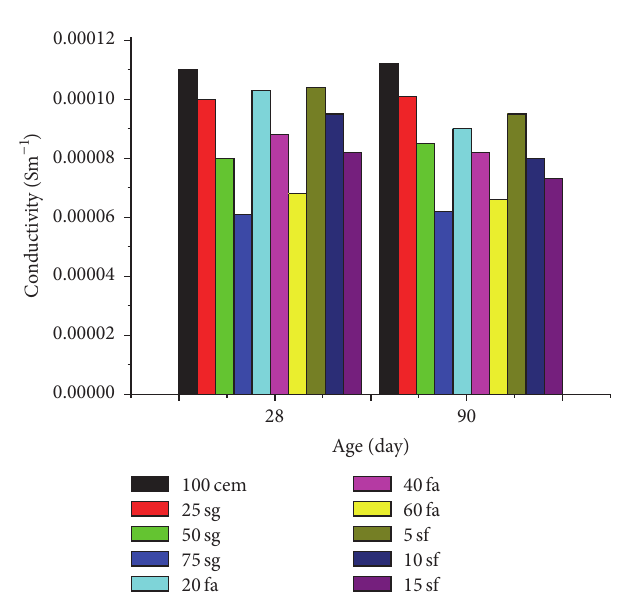
Figure 6: Conductivity value of different paste solutions.